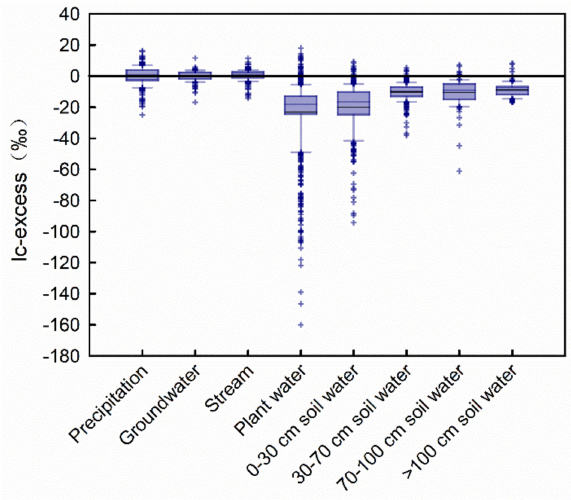
Figure 2. Evaluation of the ES hypothesis based on the line-conditioned excess (lc-excess) method, i.e., comparing the lc-excess values of distinct pools. Box plot shows the maximum, upper quartile, average, median, lower quartile and minimum. Data from